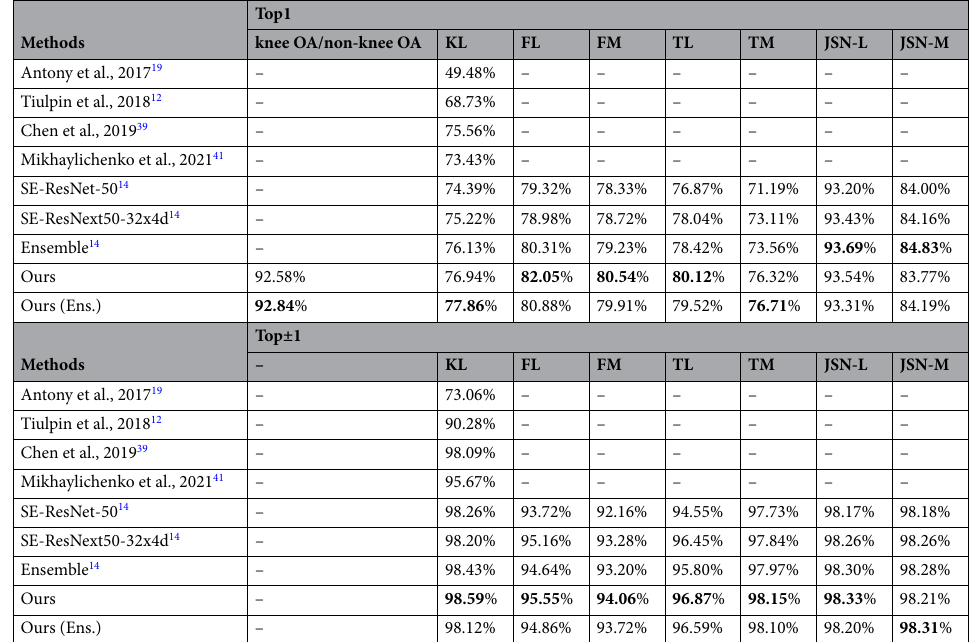
Table 2. Performance comparison between the proposed method and other methods on the MOST